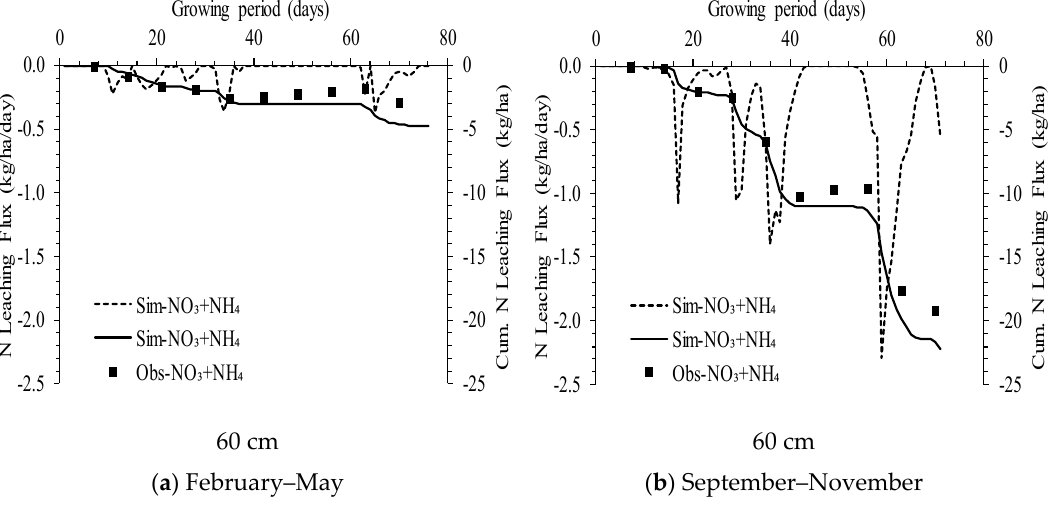
Figure 11. Simulated (Sim.) N leaching fluxes, cumulative N fluxes and observed (Obs.) cumulative N fluxes at 60 cm depth during the ( a ) first season and ( b ) second season.